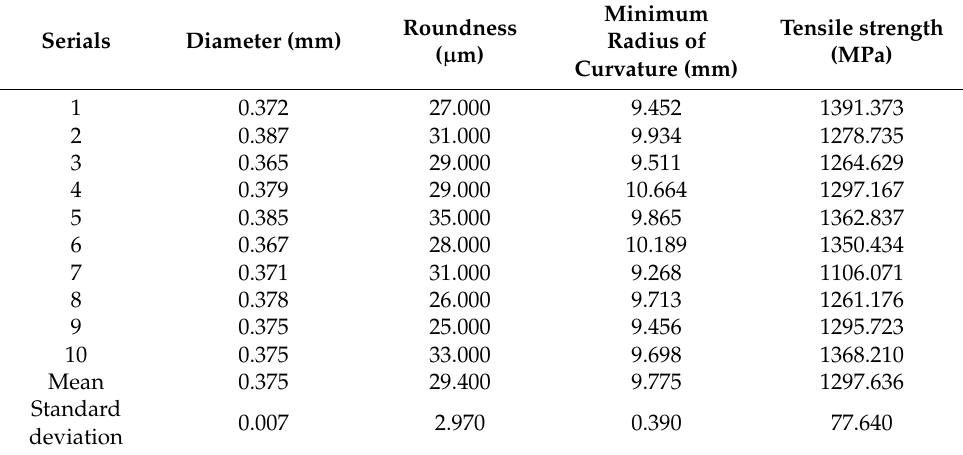
Table 11. The CCFRCF/PC performance index in optimized preparation process parameters.